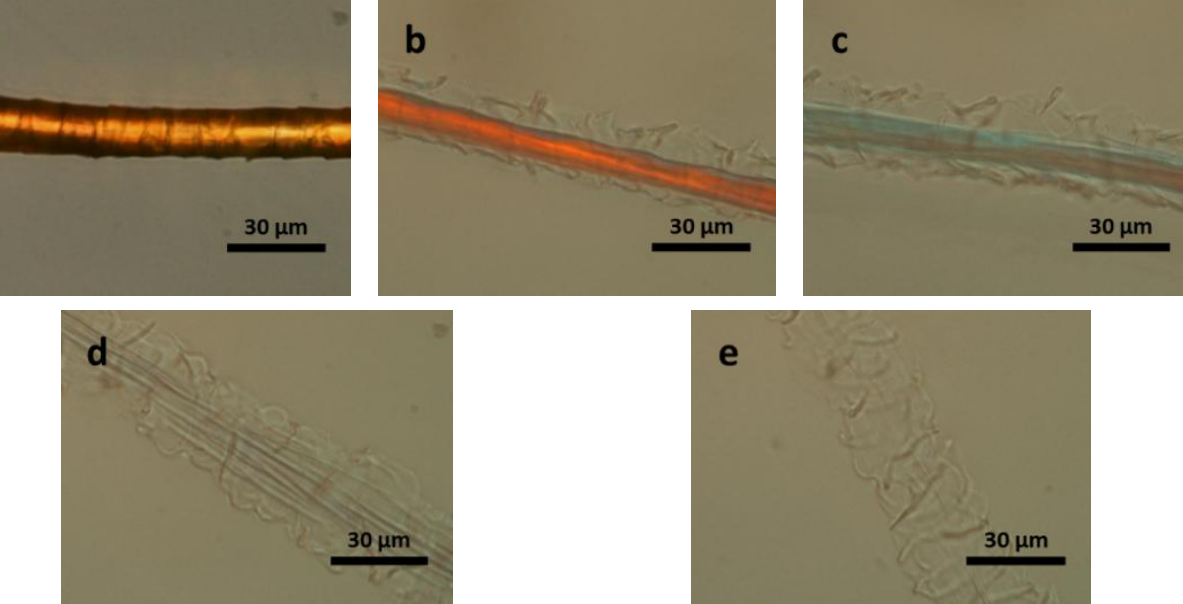
Figure 2. Polarizing optical microscope (POM) images of a wool fibre in [Bmim]OAc at 120 °C: ( a ) original wool fibre; for ( b ) 5 s; ( c ) 50 s; ( d ) 100 s; and ( e ) 180